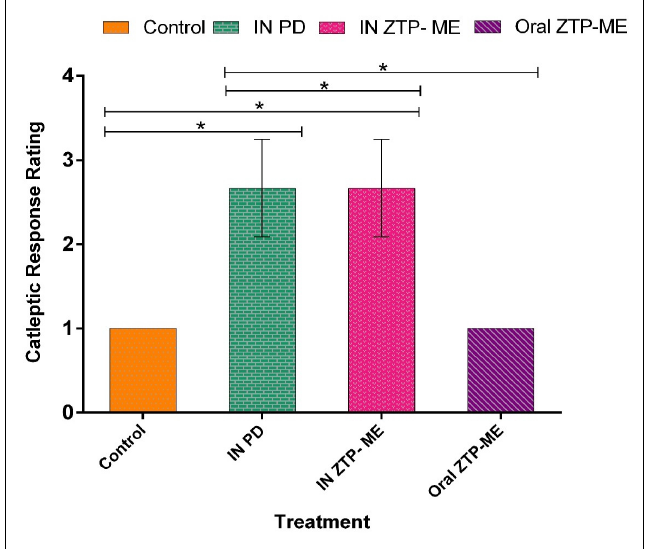
Figure 8. Cataleptic response rating following drug administration based upon the drugs treatment received. The results are expressed as the mean ± standard error ( n = 3). Cataleptic response score was less than 3 and 2 in intranasal ME and oral ME, hence not considered to be cataleptic (* p ≤ 0.05). Abbreviations: IN PD: intranasal plain drug; IN ZTP ‐ ME: intranasal zotepine microemulsion; Oral ZTP ‐ ME: oral zotepine